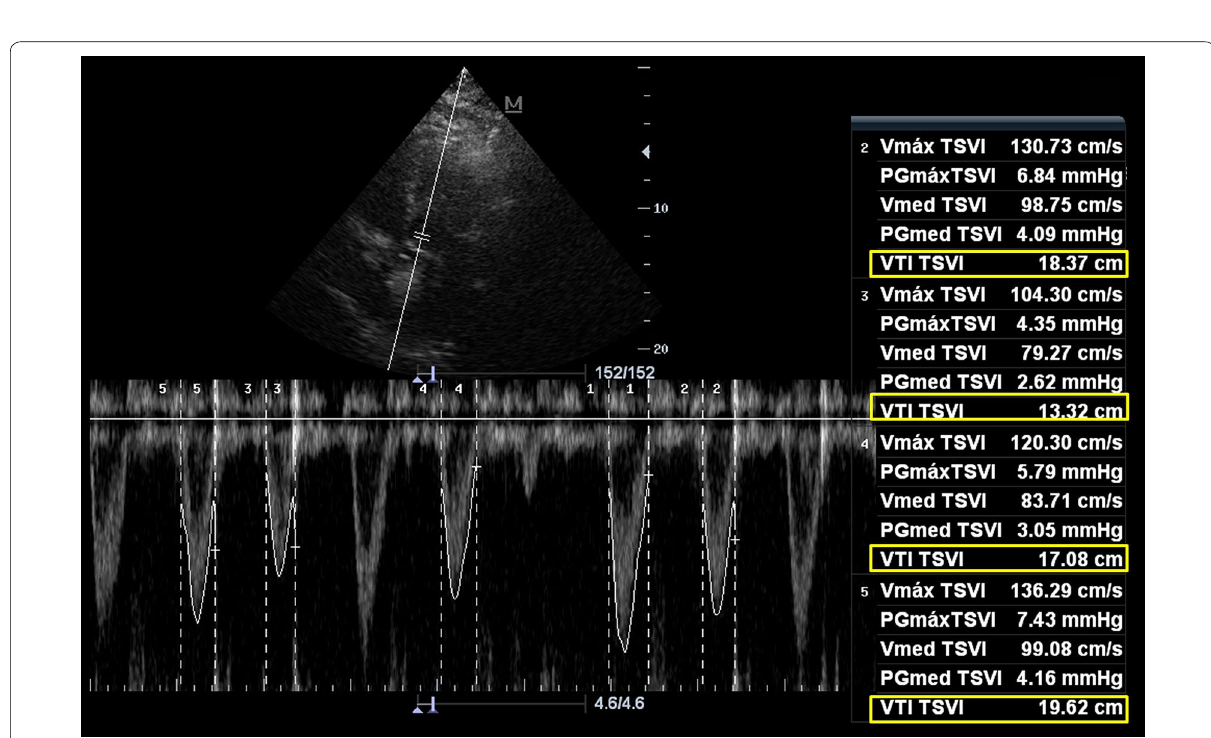
Fig. 8 Averaging several left ventricular tract velocity–time integral (LVOT VTI, (yellow boxes)) for obtaining a mean VTI in the context of atrial